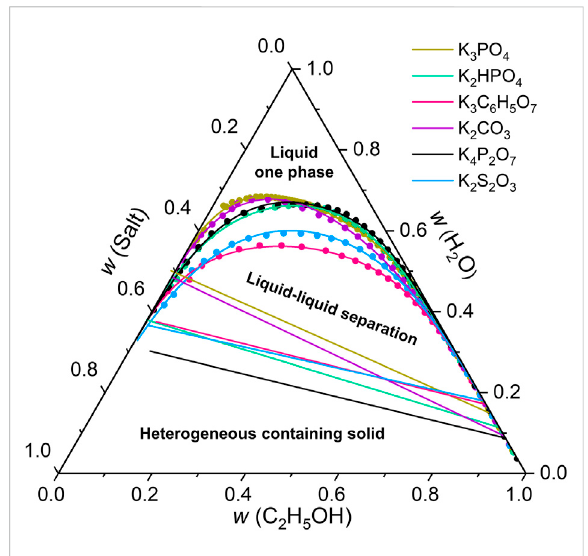
FIGURE 2 Ternary phase diagram of ethanol/water/salts. The binodal curve was obtained by cloud point titration. The boundary between biphasic and triphasic zone was a line segment, determined by its eutectic points, which were compositions of two liquid phases in equilibrium with a solid